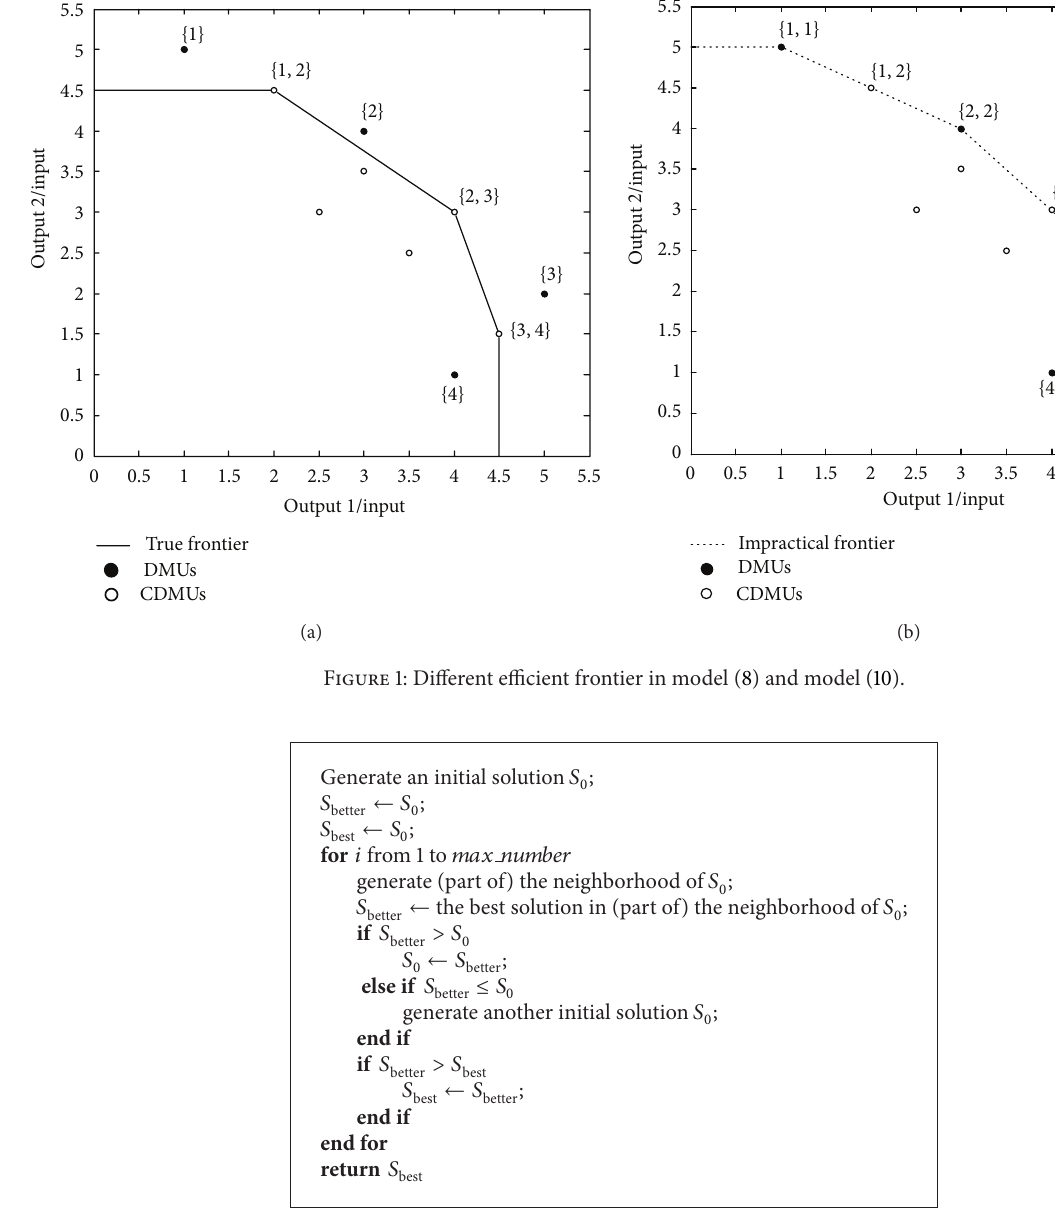
Pseudocode 1: The pseudocode of the basic local search